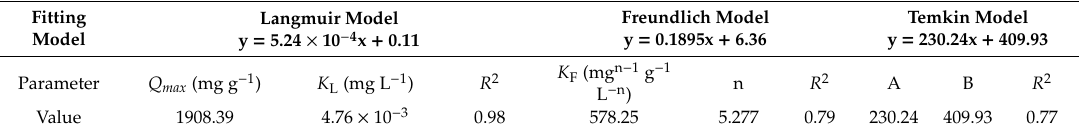
Table 3. Comparison parameters of Langmuir, Freundlich and Temkin models for Pb(II) adsorption by